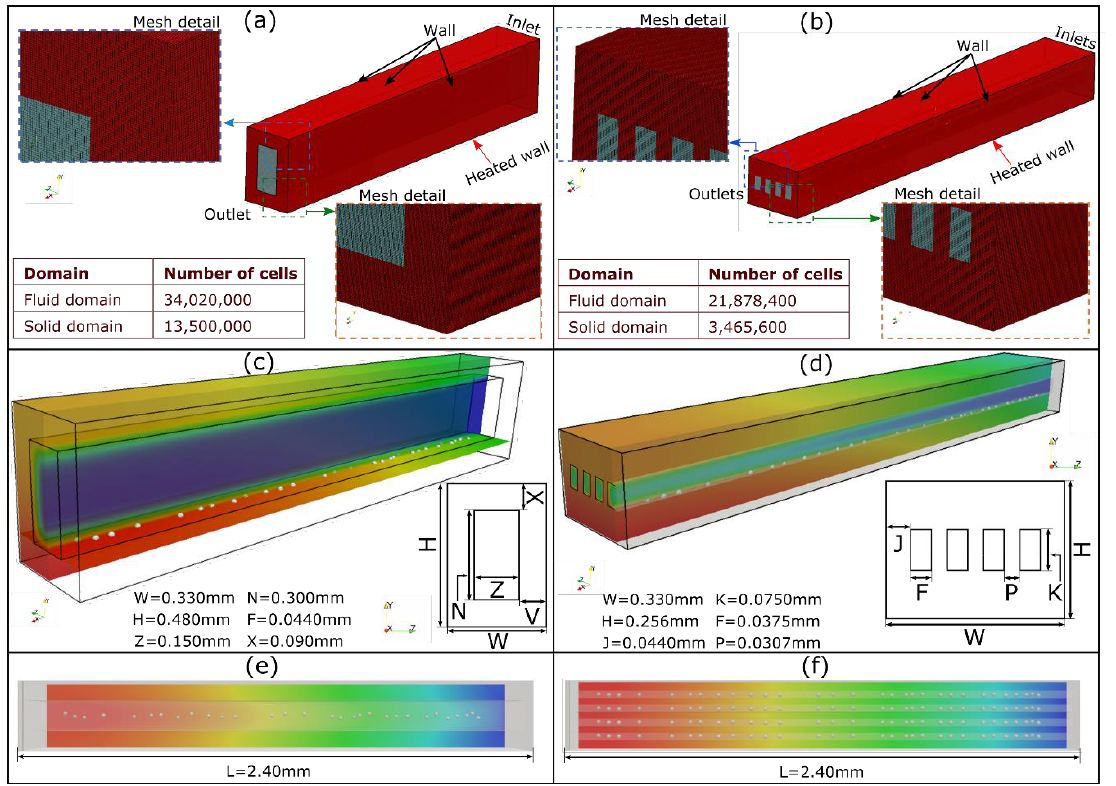
Figure 6. Left — case with single microchannel ( D h = 200 μm × 1 channel). Right — case with four parallel microchannels ( D h = 50 μm × 4 channels). ( a , b ) Computational domain and mesh details, ( c , d ) 3D angled view of the microchannel(s) and fully developed thermal boundary layer at t = 0 ms , ( e , f ) top view and patched bubbles position at t = 0 ms .